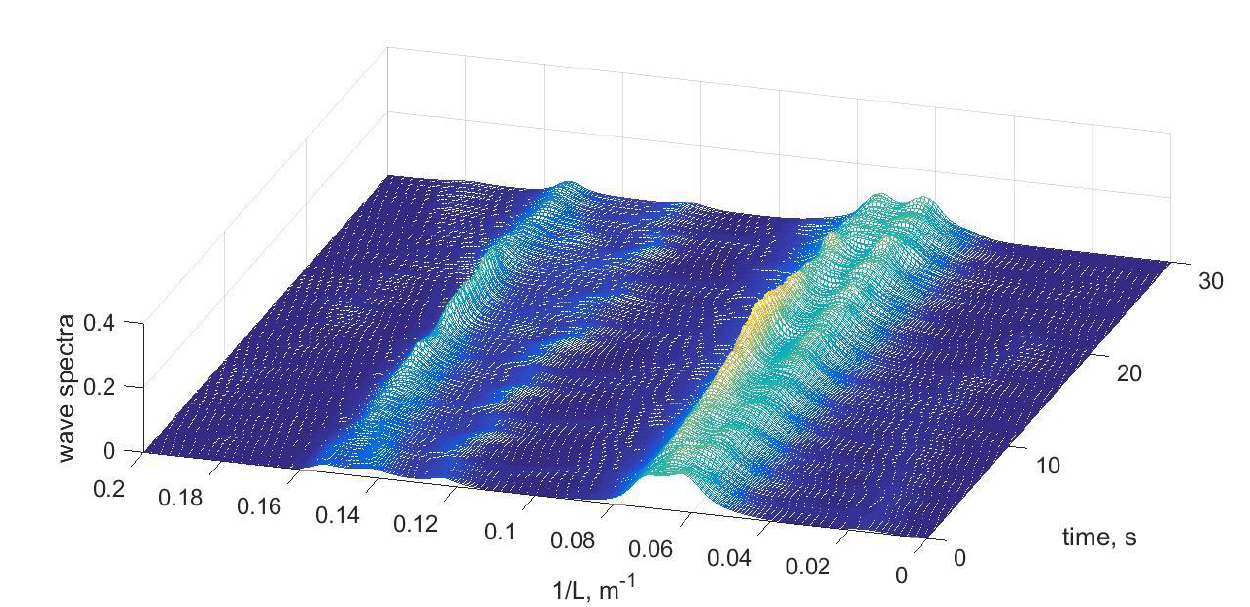
Figure 4. Evolution of wavenumber spectra of model monochromatic wave in time above bottom relief Figure 2b.